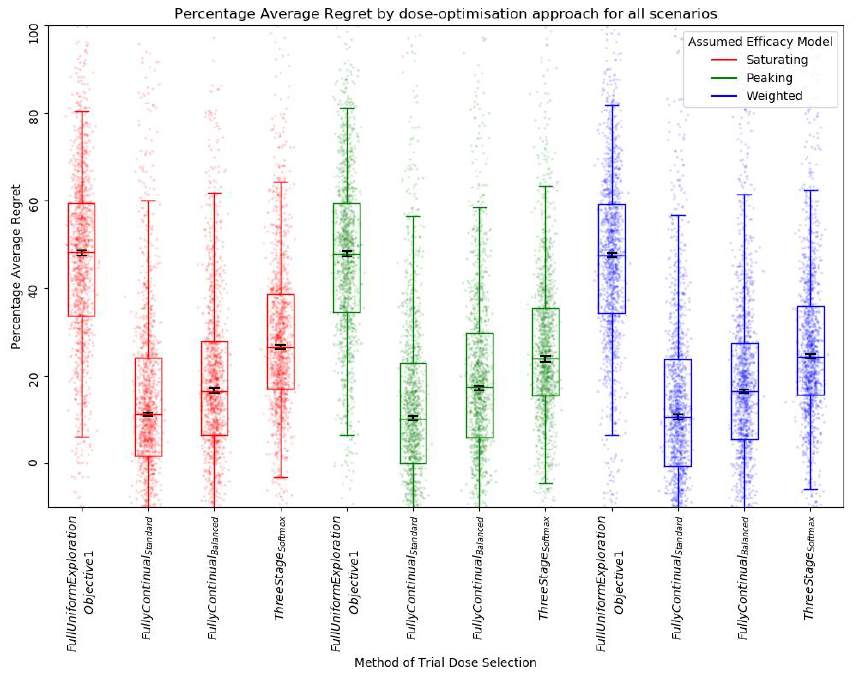
Figure 12. Percentage average regret for all scenarios by assumed efficacy model and trial dose- selection method. Trial size was 30. Individual points represent percentage average regret for a single simulated clinical trial using that dose-optimisation approach for one of the 14 scenarios. The middle line of each boxplot is the median value; the box marks the 25th and 75th percentiles, and the whiskers mark the 5th and 95th percentiles of the data. A lower percentage average regret de- notes better outcomes for trial participants. Black lines represent the 95% confidence interval for the median of each distribution [47]. The majority of these distributions of PAR were not different to a statistically significant extent at the p = 0.05 threshold according to the Kolmogorov – Smirnov test. For further details on statistical significance, see Supplementary S12. Similar plots for each individual scenario are shown in Supplementary S10 and S13. Analysis of the distributions of PSR, absolute inaccuracy, and PAR for statistical signifi- cance are given in the supplementary documents Supplementary S12. 3.2.2. Quantitative Ranking For minimising PSR, the approach assuming a weighted efficacy curve and using fully continual modelling with balanced exploration was most consistent across the sce- narios that we tested (Table 3). The fully continual modelling with balanced exploration approaches outranked the standard fully continual modelling approaches for each effi- cacy model. The three-stage softmax approaches also performed well, along with the ap- proach with full uniform exploration with an assumed peaking efficacy curve. This may suggest that when assuming a peaking curve shape, exploration improves final dose se- lection. For minimising average regret, the standard fully continual modelling approach as- suming a peaking efficacy curve was most consistent across the scenarios that we tested. The shape of the model ’ s efficacy curve was less important than the method of trial dose selection for minimising average regret, with the order from worst to best being full uni- form exploration, three stage softmax, balanced fully continual modelling, and standard fully continual modelling. This may suggest that for small trial sizes (30), the standard fully continual modelling approach is most ethical, as the average regret was lowest.